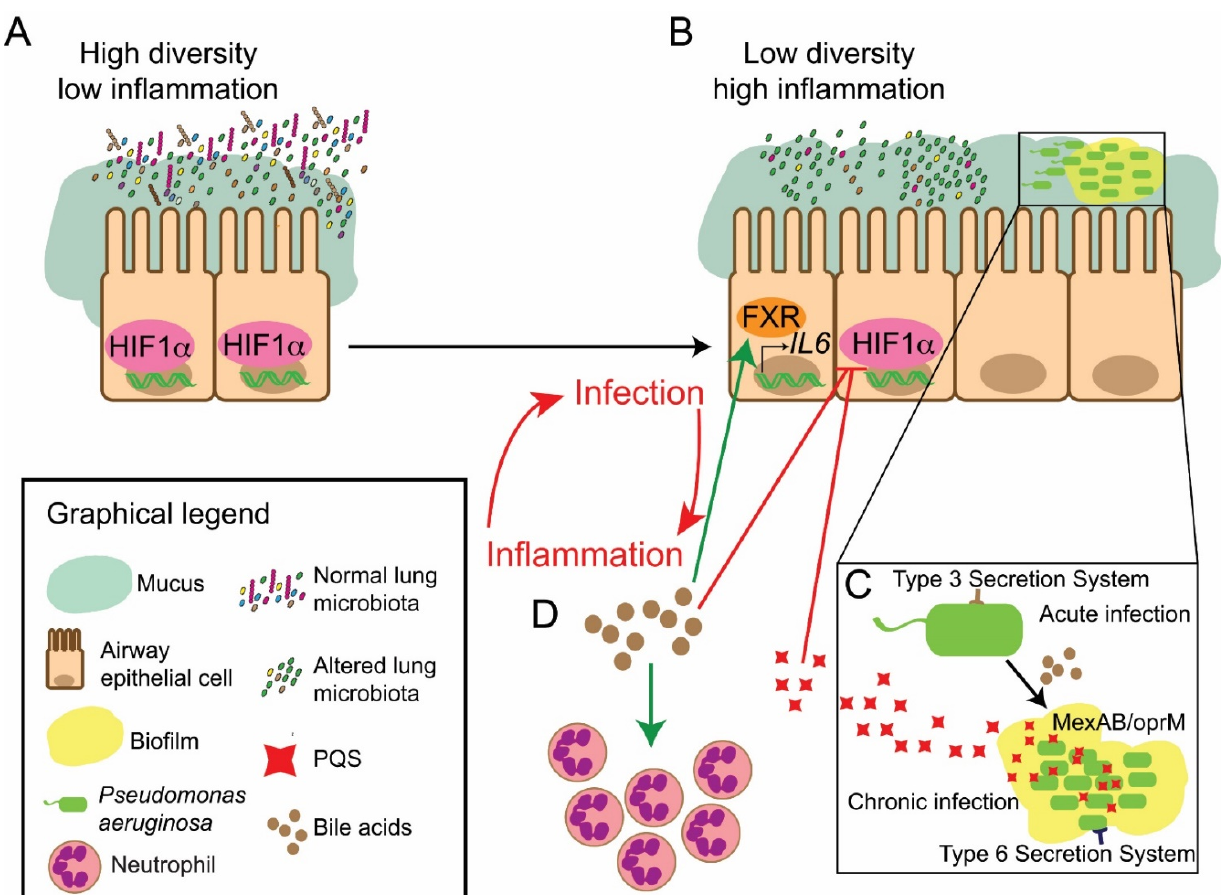
Figure 2. Overview of the proposed BA ‐ microbiota axis within the CF holobiont. ( A ), ( B ) The accumulation of BAs within the lungs of patients with CF as a consequence of aspiration leads to changes in the structure of the lung microbiota. This results in a transition from an ( A ) high diversity stable community to a ( B ) pathogen ‐ dominated low diversity population. ( B – D ) Modulation of host signalling through the HIF ‐ 1 transcription factor by BAs and bile ‐ induced P. aeruginosa derived Pseudomonas Quinolone Signal (PQS) serves to further promote dysregulated inflammation in CF patients. The impact of BAs on the behaviour of the key CF ‐ associated pathogen P. aeruginosa ( C ) leads to a switch towards a chronic antibiotic tolerant biofilm lifestyle, with increases in PQS, the MexAB RND efflux pump and the Type Six Secretion System (T6SS), in parallel with a reduction in T3SS. ( B – D ) There is a dual impact of BAs on the lung microbiota, promoting chronicity and the inflammatory response. BAs also cause an FXR ‐ dependent induction of pro ‐ inflammatory cytokines and, consequently, the chemoattraction of neutrophils. This evidence underscores the unifying principle of BAs as a major host factor promoting the progression of chronic respiratory disease.